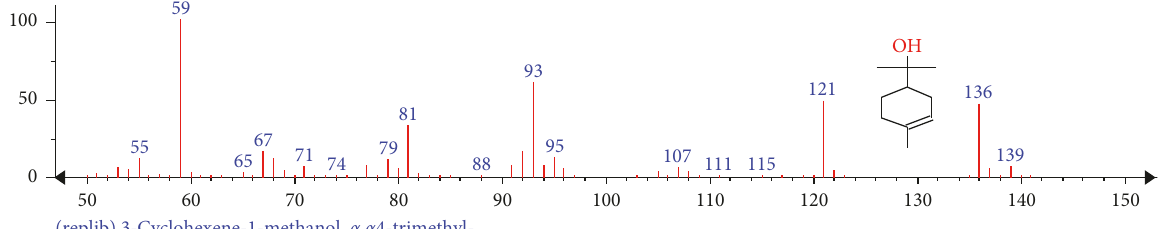
Figure 16: Mass spectrum of compound 3-cyclohexene-1-methanol, α,α 4-trimethyl- of whole plant hexane fraction of Achillea wilhelmsii (WHFAW).